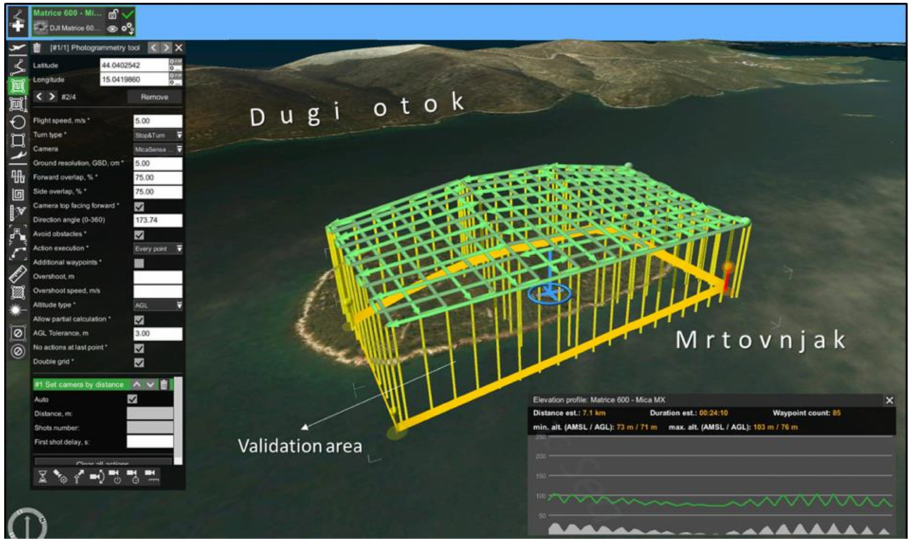
Figure 5. Parameters and the spatial extent of the multispectral UAV photogrammetric survey planned over the validation area within